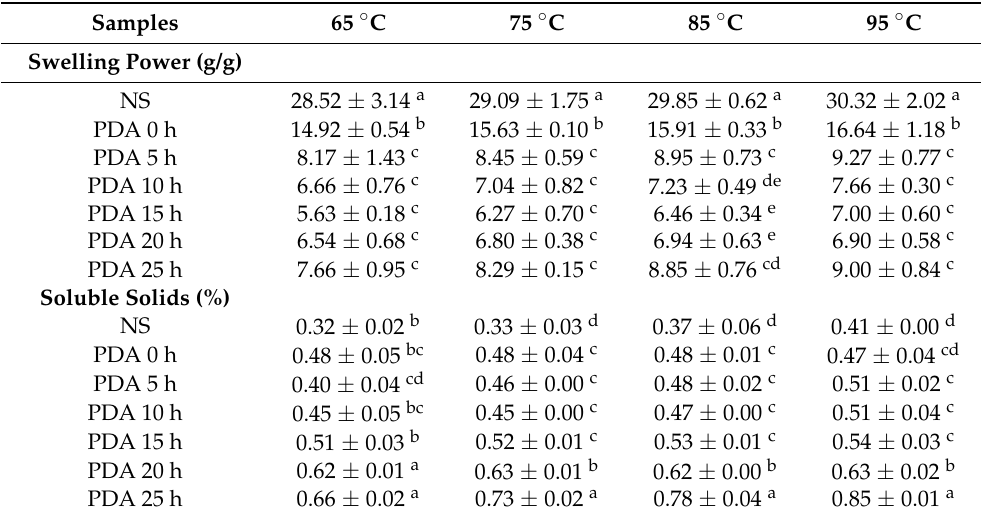
Table 5. Swelling and solubility of native and modified purple sweet potato starches. Samples